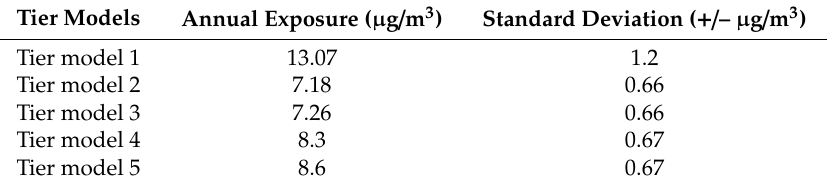
Table 4. Annual exposure calculated in each model